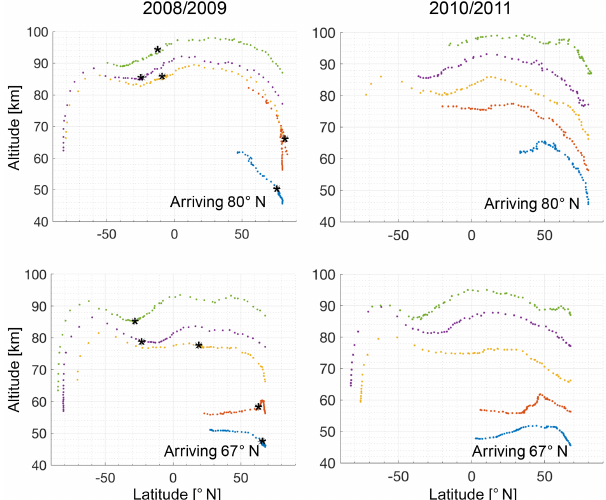
Figure 2. Trajectories of air parcels advected backwards 60 days in time from 28 February 2009 and 2011, by the TEM circulation us- ing SD-WACCM. Trajectories are calculated for air parcels arriving at 67 and 80 ◦ N, at 46, 56, 66, 76, and 86km altitude and locations are plotted at midnight each day. Parcel positions on 28 January 2009 (start date of an SSW) are indicated with a black asterisk. See Sect. 3 for more